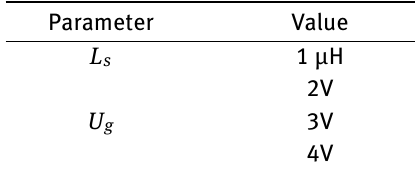
Figure 5: Simulation curve of gate voltage U gs under different U g conditions Table 2: Parameters to investigate the influence of driving